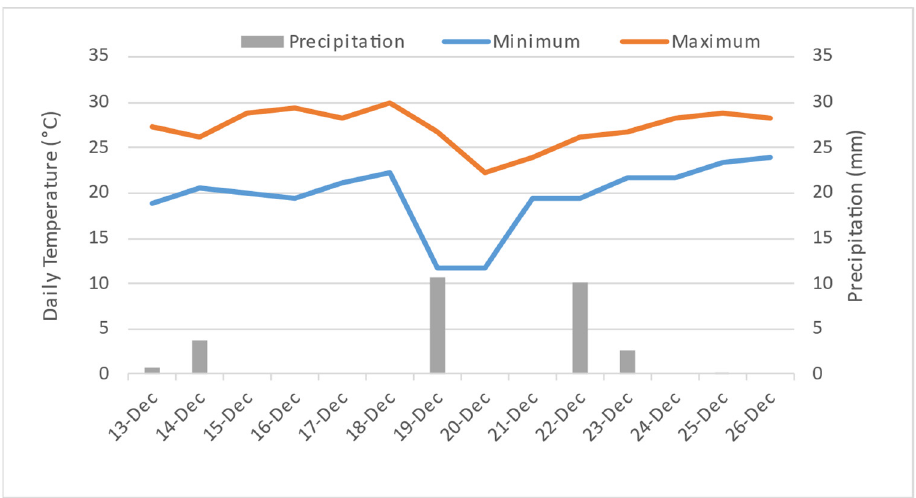
Figure 2. Daily maximum and minimum temperature and precipitation for two weeks before harvest in 2015. Recordings from the U.S. Climate Data (Station of Ft. Pierce Florida, 10 km from the farm) (https://www.usclimatedata.com/climate/fort-pierce/florida/united-states/usfl0156, accessed on 10 May 2021).